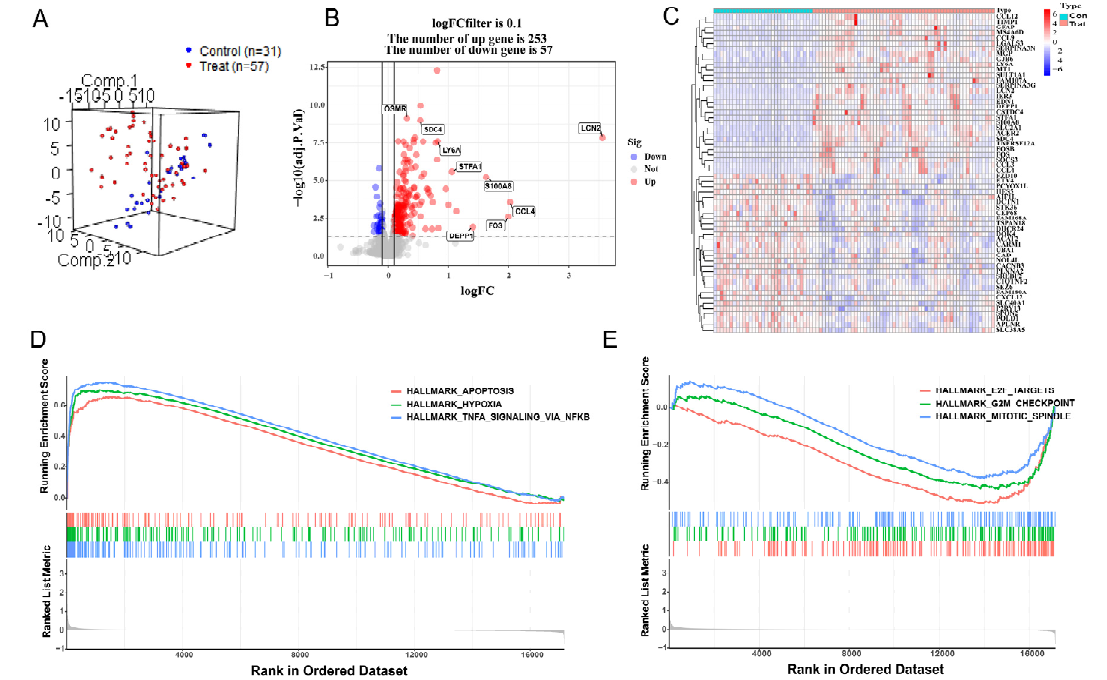
Figure 1. Differentially expressed gene analysis and gene set enrichment analysis. ( A ) Distribution of samples based on the whole genome expression data. ( B ) The volcano plot shows up-regulated and down-regulated genes. ( C ) Heatmap of the 60 most differentially expressed genes based on GSE23333. Light blue is the control group, red is the treatment group, and the color intensity (from red to blue) indicates the higher to lower expression. ( D ) Three up-regulated pathways. ( E ) Three down-regulated pathways.